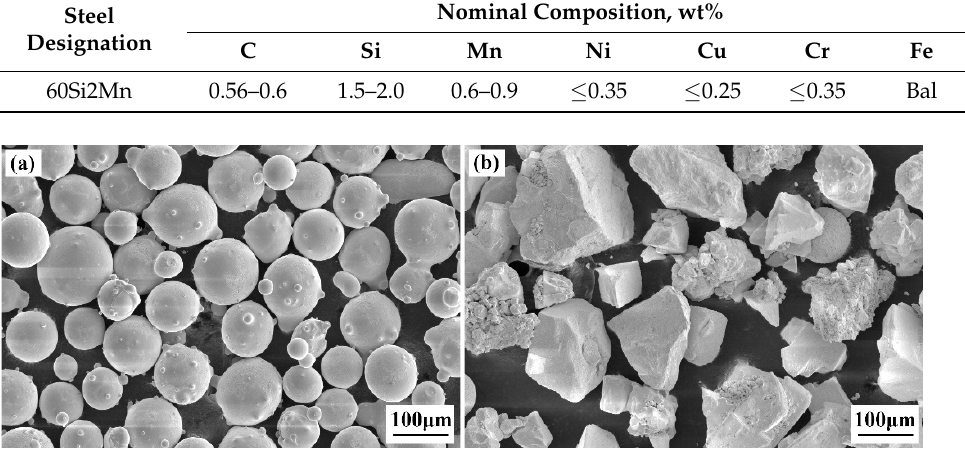
Figure 1. SEM morphology of the cladding material: ( a ) Stellite 6 powder; ( b ) WC powder. Table 1. Chemical composition (wt%) of 60Si2Mn steel substrate material. Table 2. Chemical composition (wt%) of Stellite 6 cladding